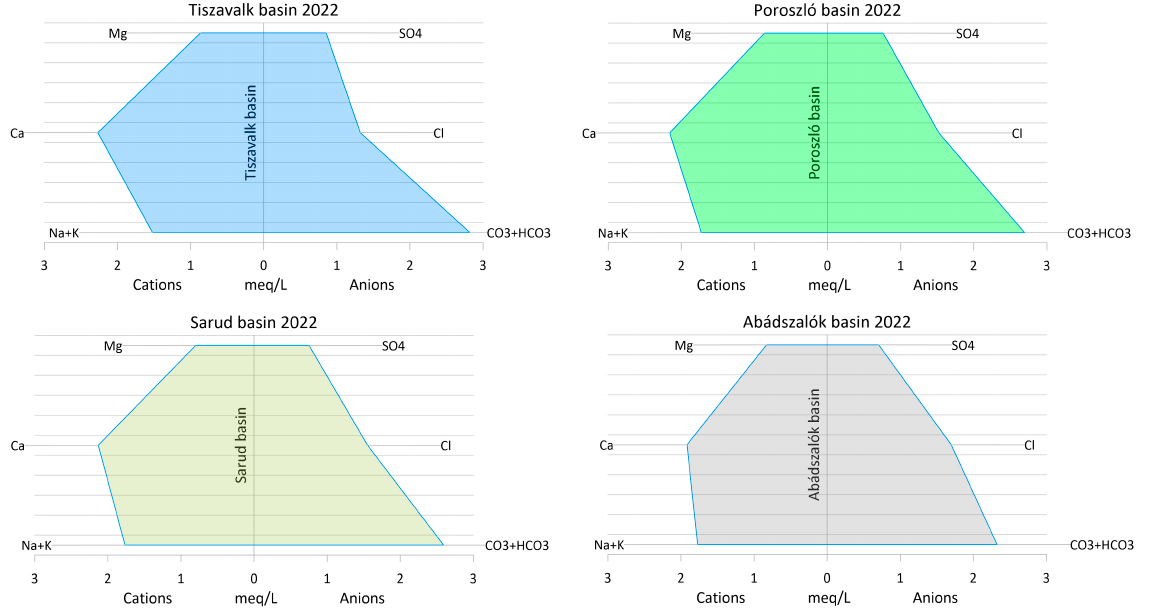
Figure 7. Sti ff diagrams for the di ff erent basins of Lake Tisza in 2022. Figure 7. Stiff diagrams for the different basins of Lake Tisza in 2022.